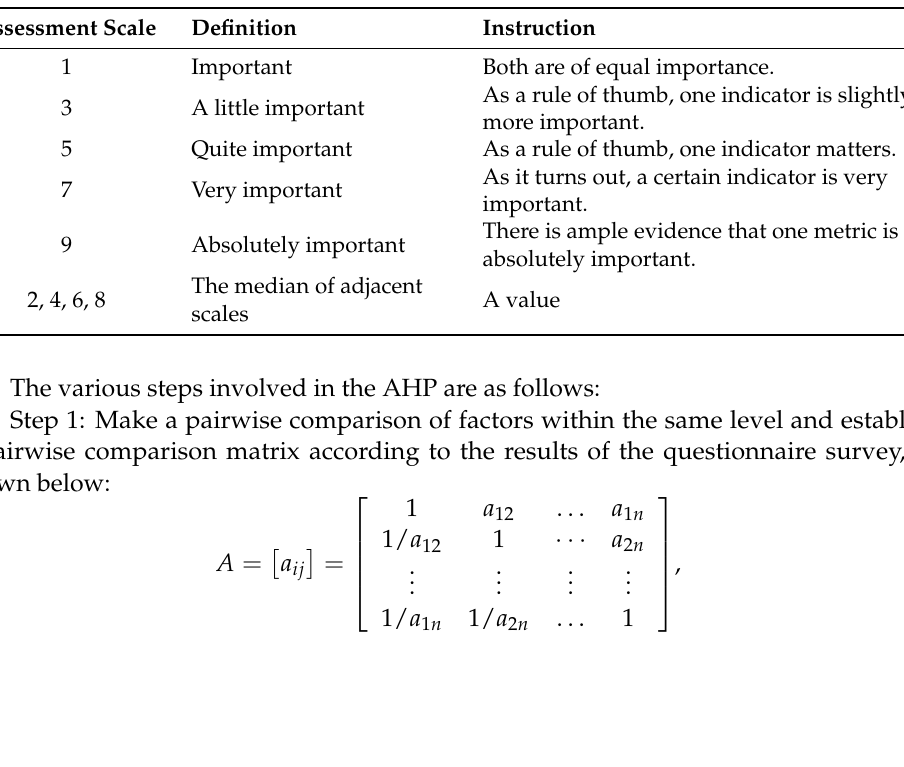
Table 1. AHP assessment